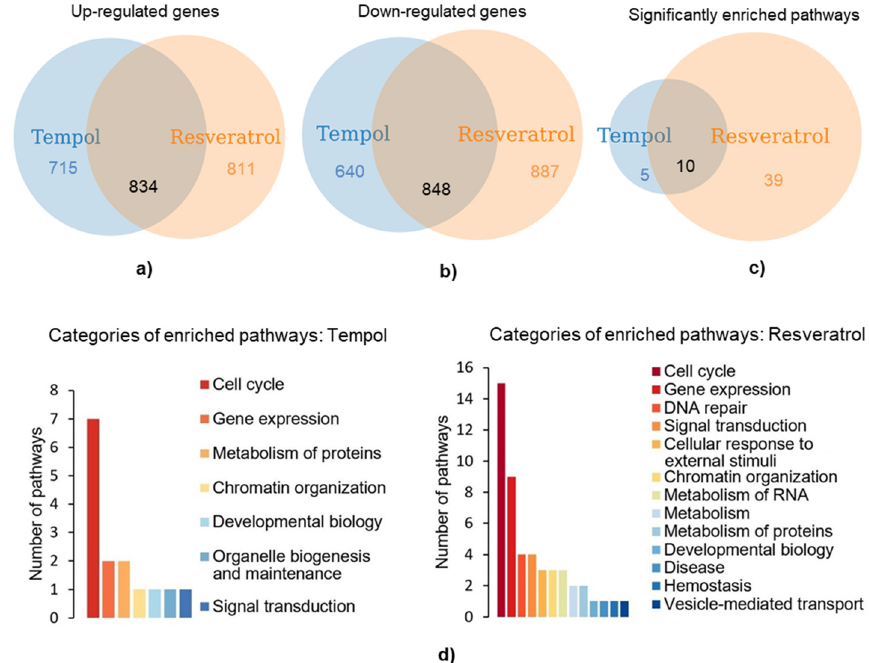
Figure 3. Transcriptomic analysis of AO-stressed MSCs: pathway enrichment analysis; ( a , b ) gene sets containing genes with an expression fold change increase or decrease greater than 1.5 used for pathway analysis; ( c ) Sets of pathways significantly ( p -value ≤ 0.05, Benjamini and Hochberg analysis) enriched after AO treatments; ( d ) core categories to which the pathways enriched by each antioxidant belong. Abbreviations: human mesenchymal stem cells (MSCs),